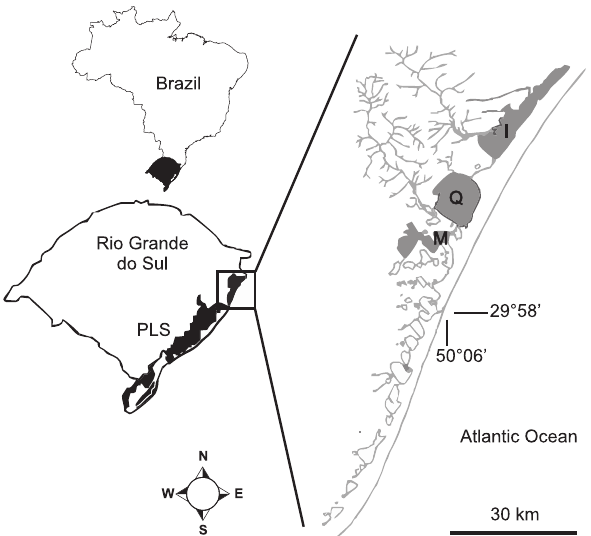
Figure 1. Map showing the location of the Tramandaí River system (black); Patos Lagoon system (PLS) (grey) and the coastal lagoons sampled: Itapeva (I), Quadros (Q) and Malvas (M) in the state of Rio Grande do Sul,